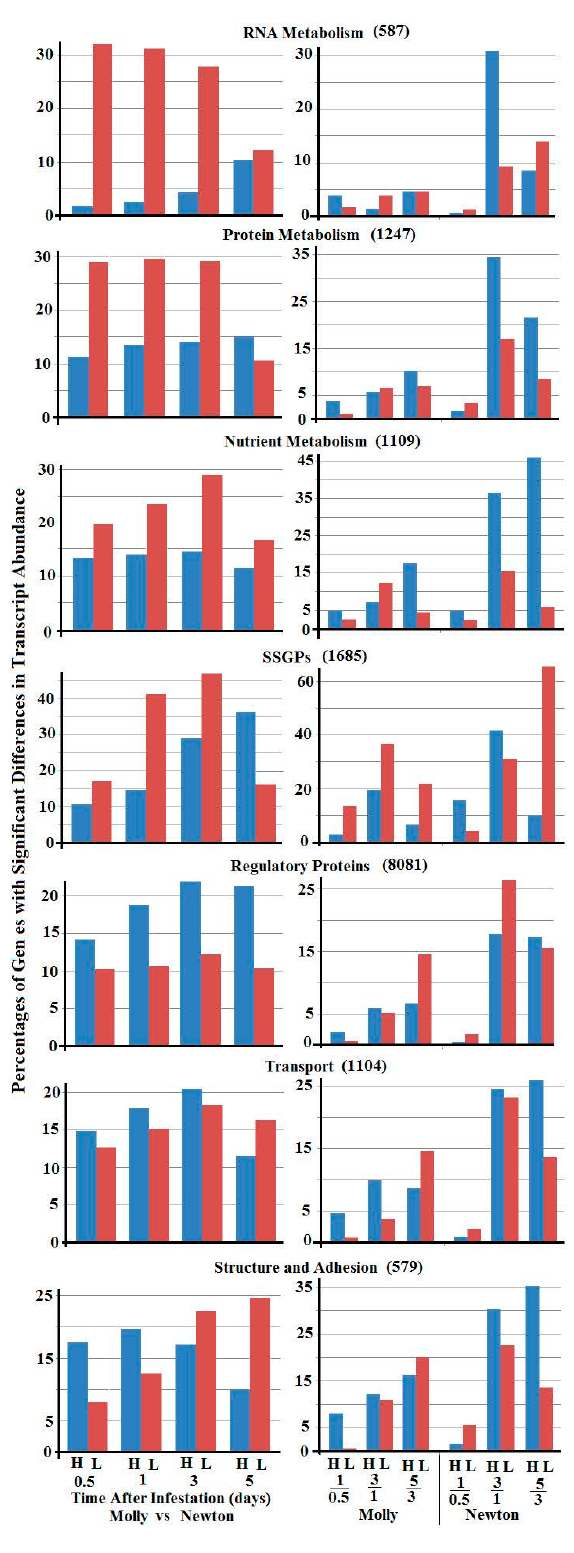
Figure 2. Percentages of genes in different functional categories with higher (blue bars. H) and lower (red bars, L) transcript abundance between larvae feeding in resistant (Molly) and susceptible (Newton) plants at 0.5, 1, 3, and 5 days ( left panels), and between two successive stages (1 versus 0.5 day, 3 versus 1 day, and 5 versus 3 days) of Hessian fly larvae feeding in either resistant (Molly) or susceptible (Newton) plants ( right panels). Gene categories are marked on each pair of graphs. The numbers of genes in each category were given in parenthesis.